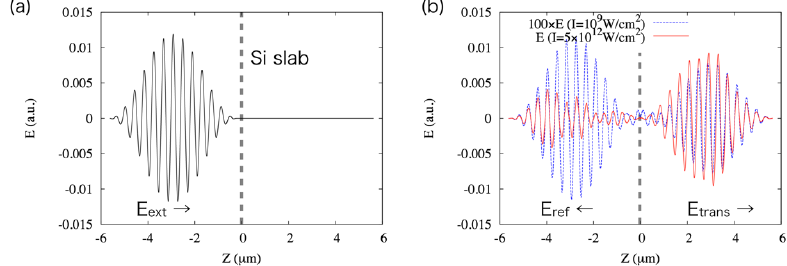
Fig. 1. Snapshots of the electric field averaged over the x-y plane (parallel to the surface) of the typical Si slab calculation. (a) Right-going incident field with the intensity I=5 × 10 12 W/cm 2 . (b) Reflected and transmitted fields with the intensity I=5 × 10 12 W/cm 2 (red solid line). The I=1 × 10 9 W/cm 2 fields are scaled up by factors of 100 (blue dashed line).